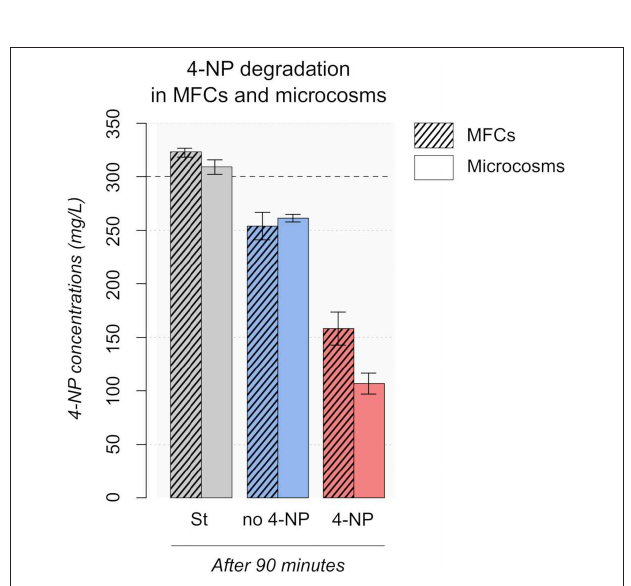
FIGURE 6 | 4-NP degradation in MFCs and microcosms. 300 mg/L 4-NP dashed horizontal line on graph, was added after 25 days of operation. The 4-NP concentrations were measured after 90 min. Footnote: St, Sterile; no 4-NP, no previous exposure to 4-NP; 4-NP, enriched with 50 mg/l 4-NP after 10